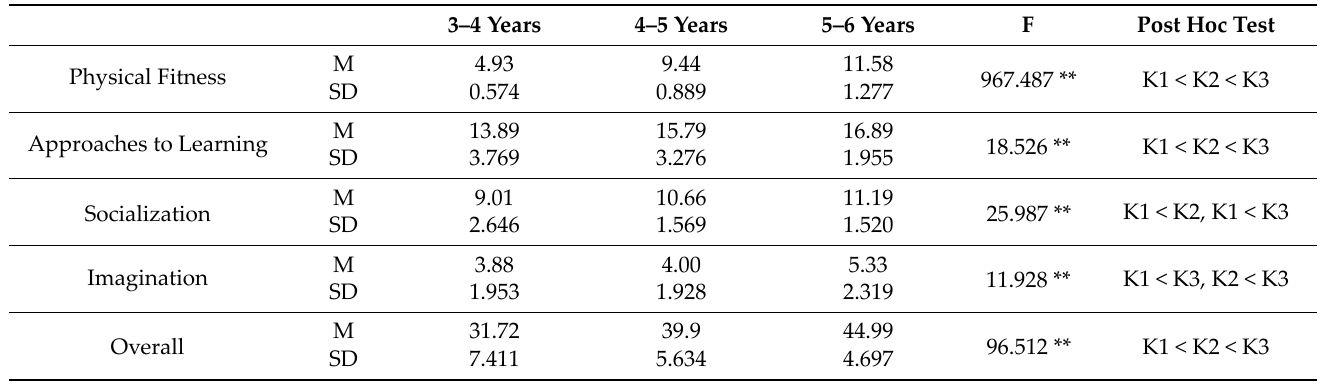
Table 6. Outdoor Free Play Performance of Children of Different